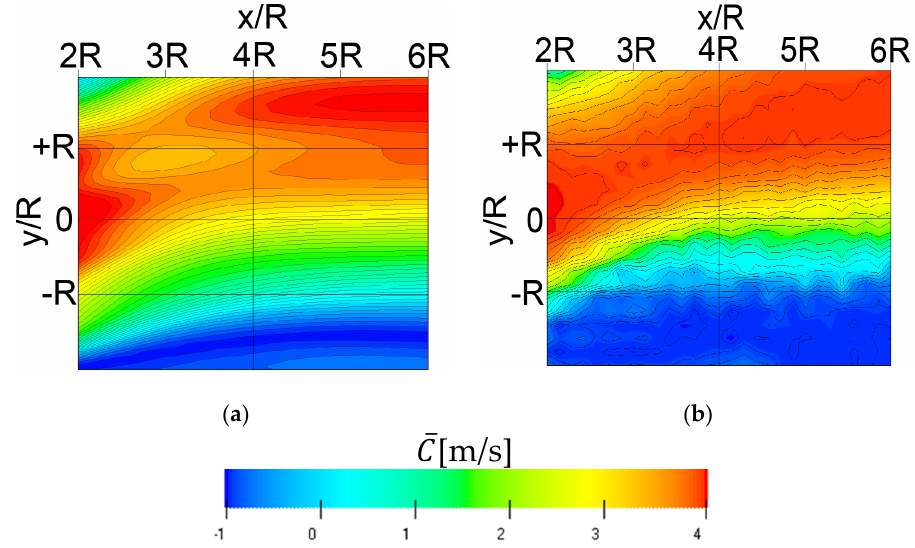
Figure 16. Outlet flow field contours for ( a ) CFD and ( b ) LDA.